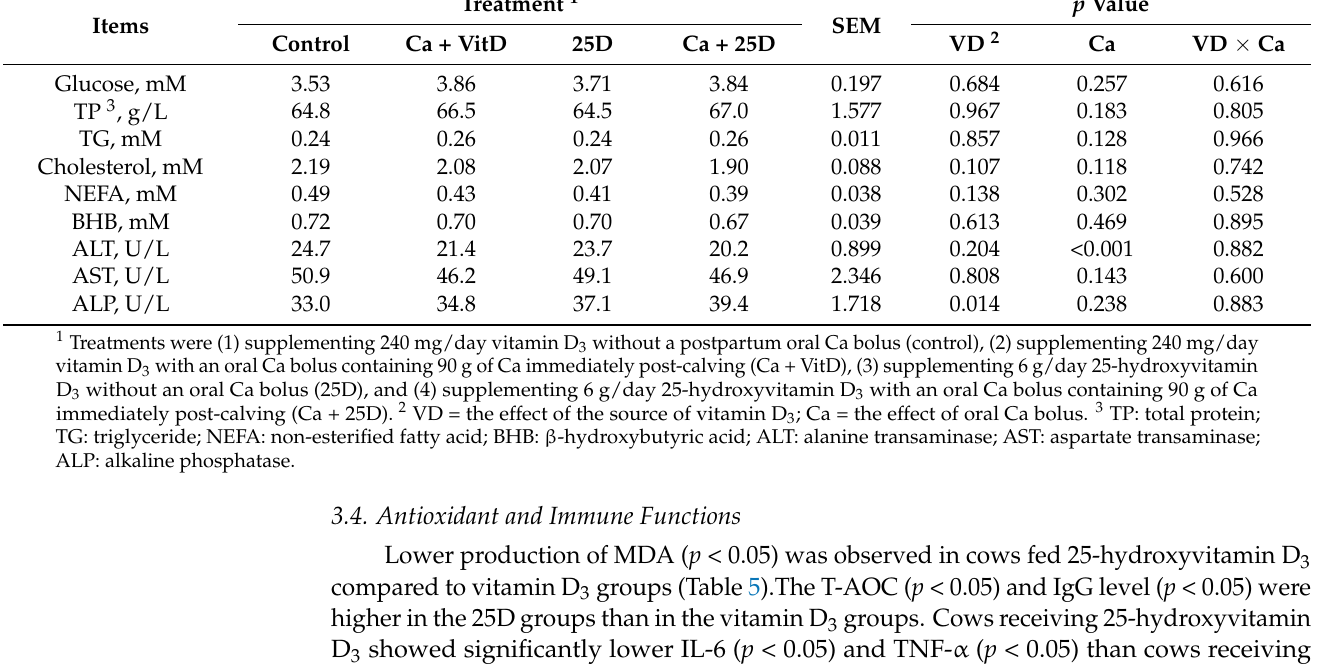
Table 4. Effect of 25-hydroxyvitamin D 3 and oral calcium bolus on blood biochemistry of postpartum Holstein cows.